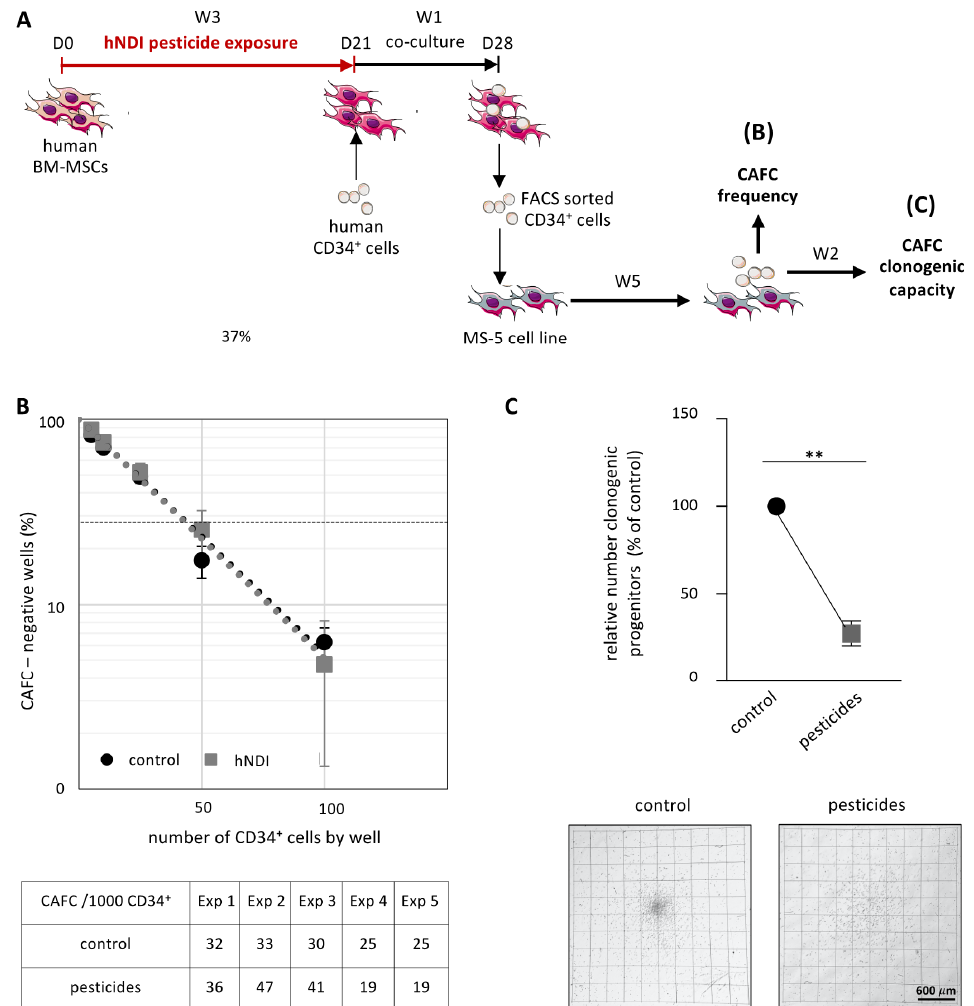
Figure 5. Exposure of BM-MSCs to pesticides alters the functionality of primitive hematopoietic progenitors. Human CD34 + cells were co-cultured for 7 days on BM-MSCs previously exposed or not for 21 days to low doses of pesticides (hNDI), and CAFC frequency was quantified by limiting dilution assays after 5 weeks on the MS-5 cell line. ( A ) Schematic representation of the experimental strategy. ( B ) Exposure of BM-MSCs to pesticides does not modify the frequency of CAFC in CD34 + cells ( n = 5). ( C ) Exposure of BM-MSCs to pesticides induces a major decrease in the clonogenic capacity (CFU-GM, BFU-E and CFU-M) of CAFC ( n = 5); representative morphological features of CFU-GM are shown in lower panel. Data are expressed as mean ±SEM; ** p < 0.01; Mann–Whitney test. Scalebar: 600 μ m.